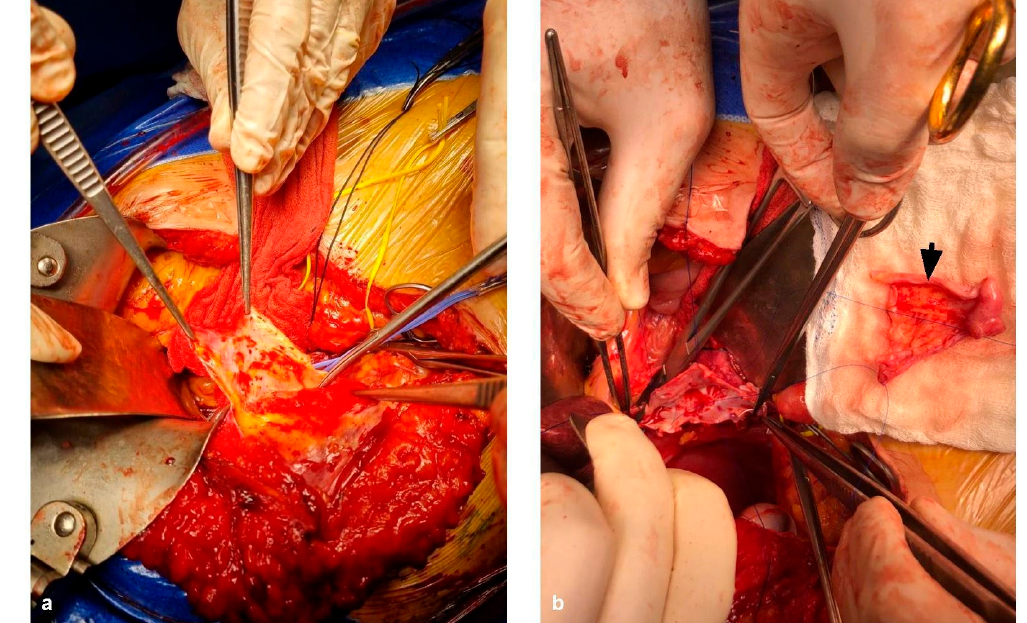
Figure 8. A patient with a large tumor invading the IVC. ( a ) The already resected and exposed endothelium of the IVC is shown. ( b ) The autologous peritoneal patch (black arrowhead), which will be used to close the defect, is shown. It should be noted that the epithelized side of the patch should always face inwards into the vascular lumen.